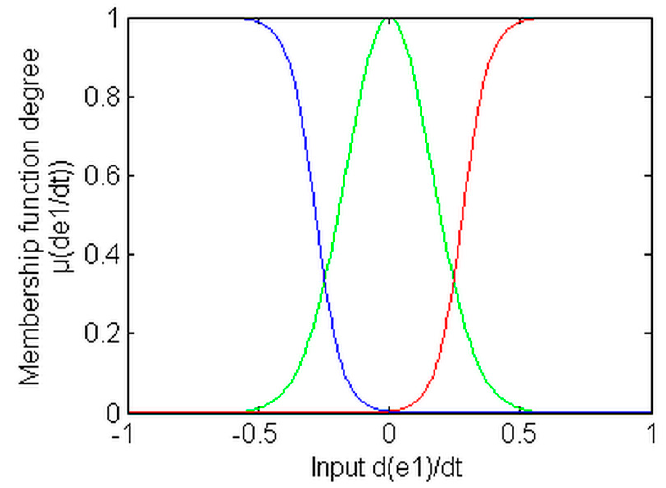
ˆ f . Figure 10. Membership functions used by ˆ f 1